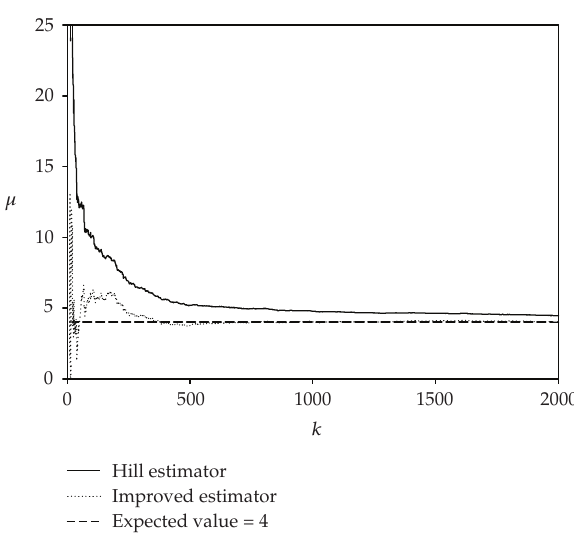
Figure 1: A Pad´e (cid:3) 0 , 4 (cid:4) behavior (cid:5) see Example 14 (cid:6)